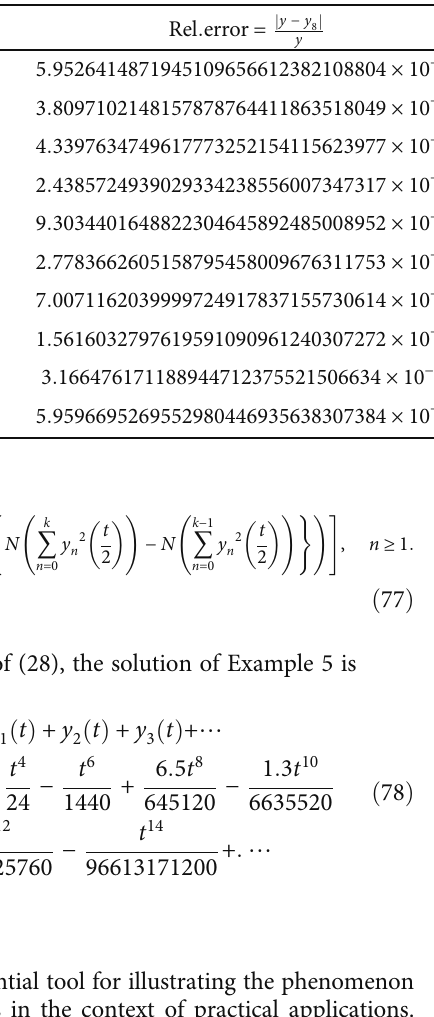
/ y and the recurrence errors j y 8 j